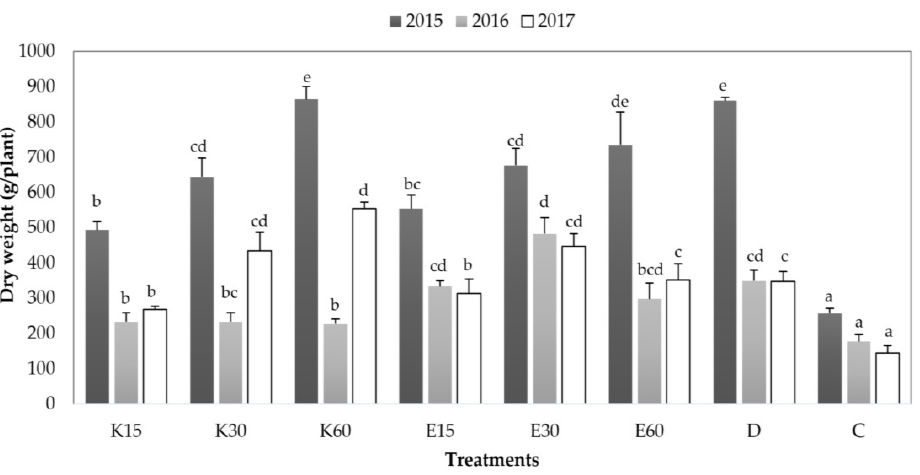
Figure 6. Biomass dry weight of short rotation willow coppice from 2015 to 2017. Average dry weight data are presented from eight treatments after harvesting. Results are means ± SD, n = 8. Different letters introduce significant differences among irrigation water qualities for the three vegetation seasons, confirming to the Games-Howell’s test at p ≤ 0.05.